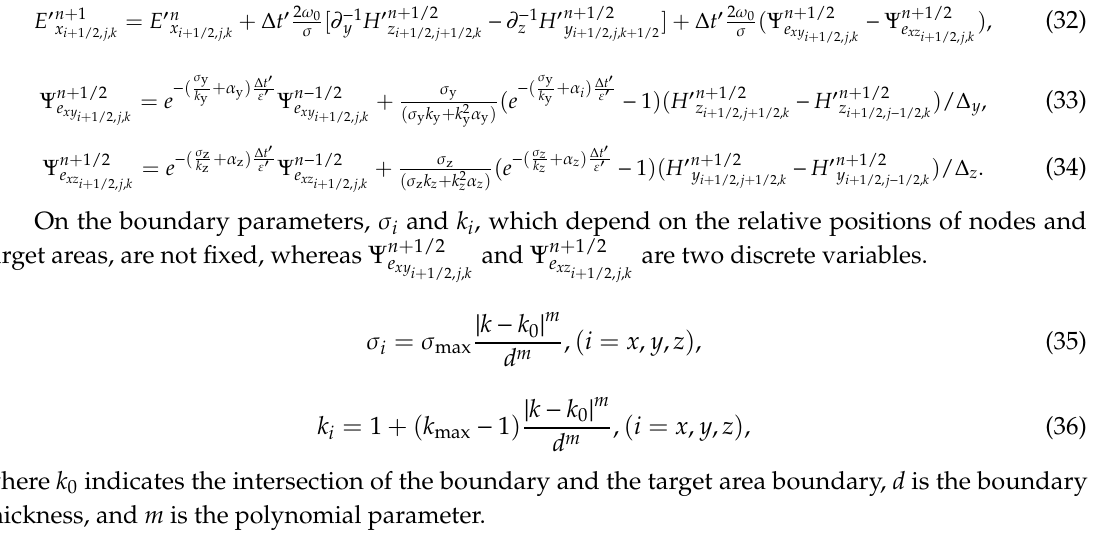
Figure 3. The response curve of the half-space model. When the earth contains the IP effects, the polarization parameters have great influence on the induced-polarization (IP) effects. In order to analyze the influence of polarization parameters on IP effects, we take the uniform half space model (Figure 2) as an example. Set the air layer conductivity 6 10